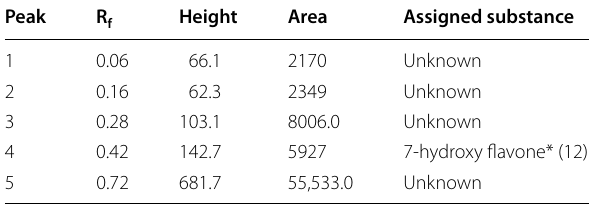
Table 11 Peak table of BPSAL in mobile phase